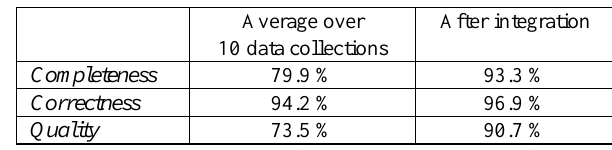
Table 1. Quality evaluation of the coarse positioning of vehicles